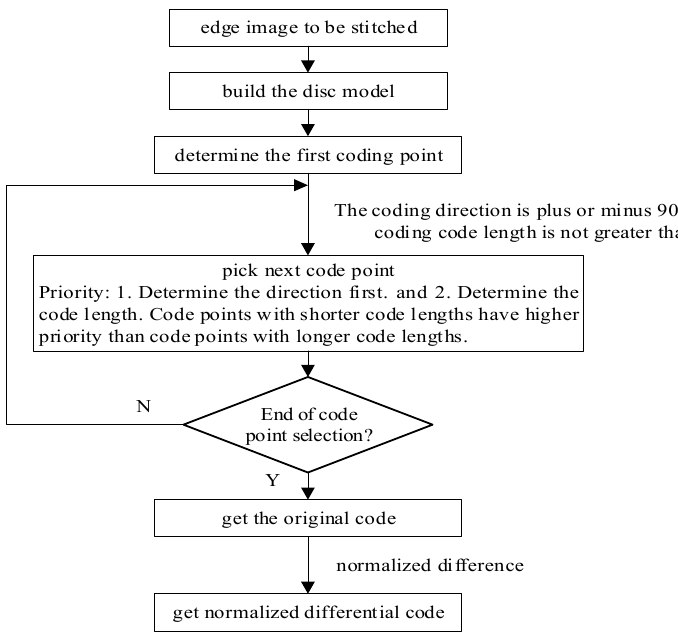
Figure 9. Code point acquisition flowchart.